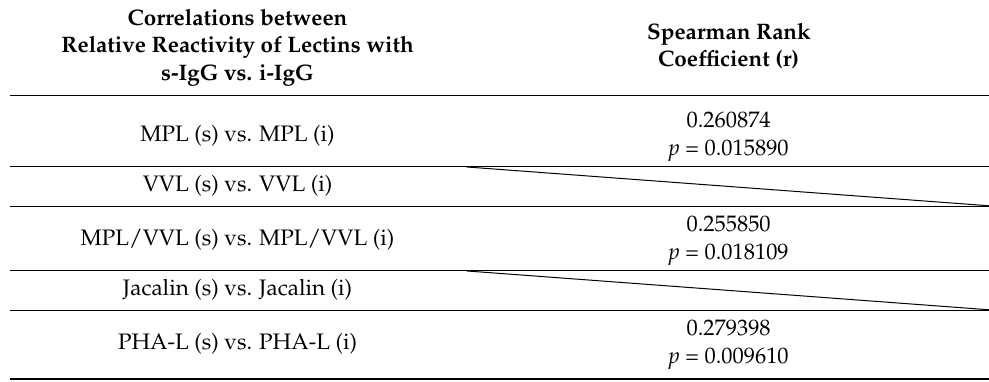
Table 3. Correlations of relative reactivities of s-IgG and i-IgG glycans with lectins. Correlations between Relative Reactivity of Lectins with s-IgG vs. i-IgG MPL (s) vs. MPL (i) VVL (s) vs. VVL (i) MPL/VVL (s) vs. MPL/VVL (i) Jacalin (s) vs. Jacalin (i) PHA-L (s) vs. PHA-L (i)